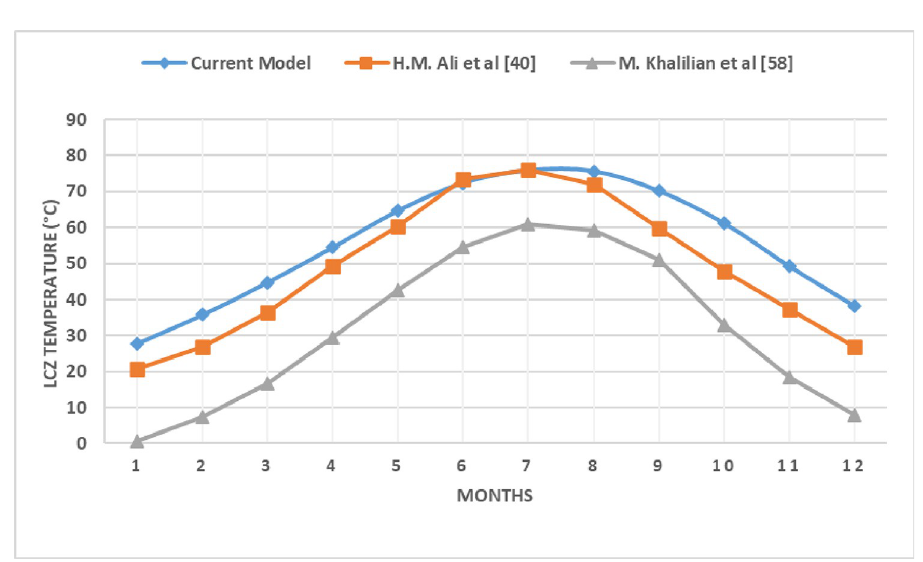
Fig 19. Validation of the proposed numerical model with experimental studies in [40, 58].